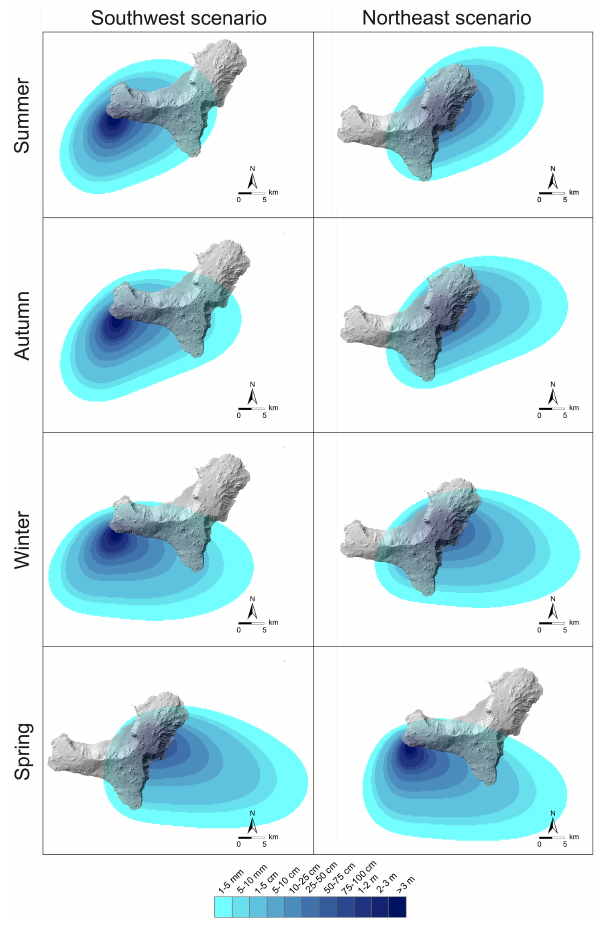
Figure 6. Ashfall scenarios from a violent Strombolian eruption performed with VORIS 2.0.1. (1) Simulation at the highest proba- bility vent; (2) simulation at an area close the main areas of popula- tion. Both simulations were performed for summer, autumn, winter and spring.